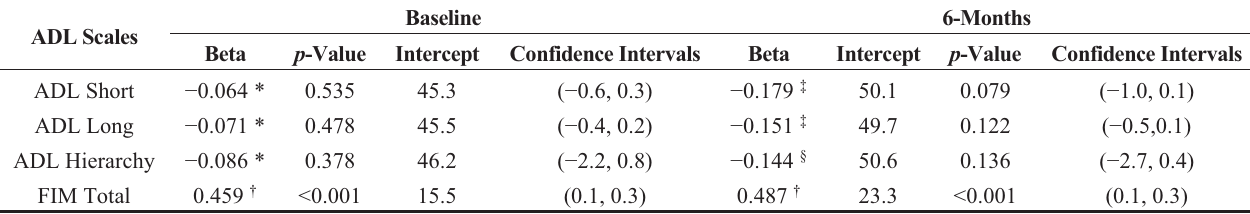
Table 4. Adjusted Regressions of ADL Scales with QOL-AD at Baseline and 6-Months. Baseline 6-Months ADL Scales Beta p -Value Intercept Confidence Intervals Beta Intercept p -Value Confidence Intervals ADL Short −0 .064 * 0.535 45.3 ( − 0.6, 0.3) −0 .179 ‡ 50.1 0.079 ( − 1.0, 0.1) ADL Long −0 .071 * 0.478 45.5 ( − 0.4, 0.2) −0 .151 ‡ 49.7 0.122 ( − 0.5,0.1) ADL Hierarchy −0 .086 * 0.378 46.2 ( − 2.2, 0.8) −0 .144 § 50.6 0.136 ( − 2.7, 0.4) FIM Total 0.459 † <0.001 15.5 (0.1, 0.3) 0.487 † 23.3 <0.001 (0.1,